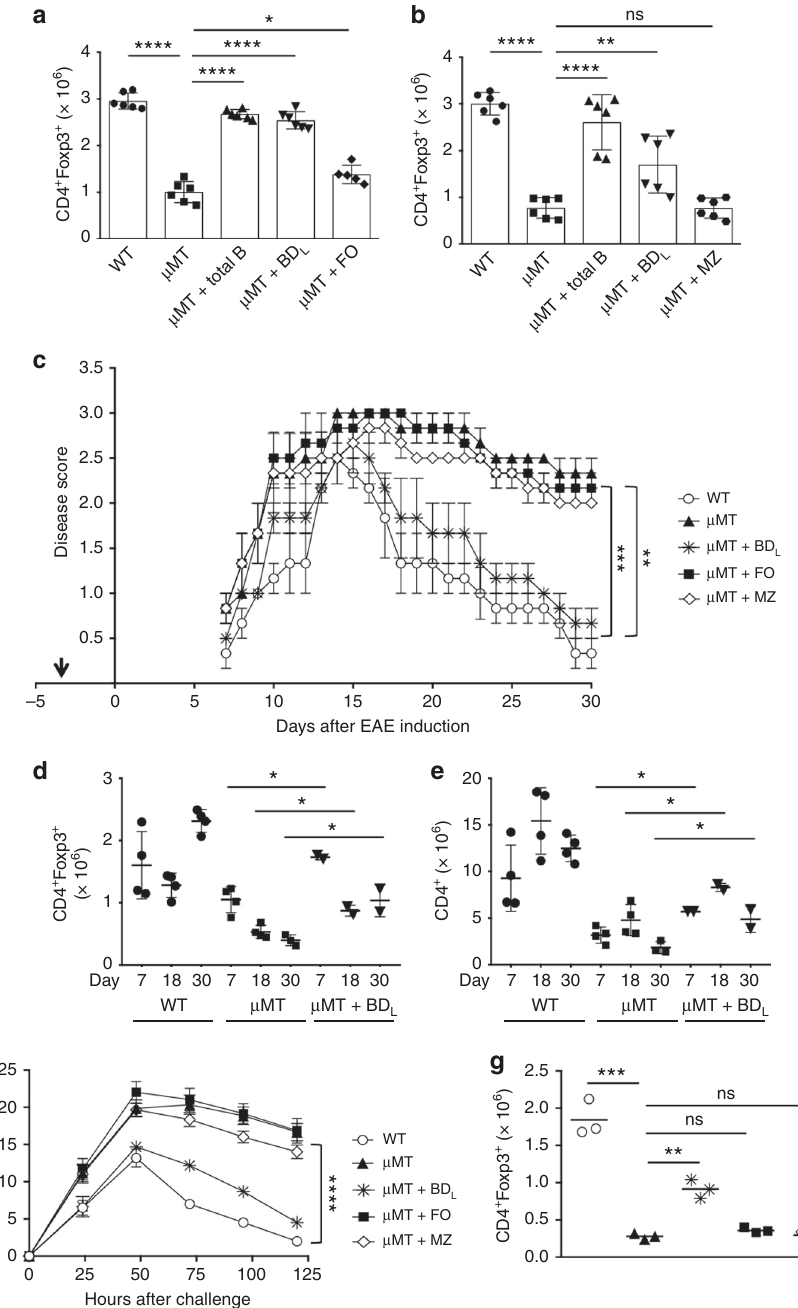
Fig. 3 Splenic BD L exhibit regulatory activity while FO and MZ B cells do not. a , b B10.PL μ MT ( μ MT) mice were treated with PBS or reconstituted with 10×10 6 FACS-puri fi ed splenic total (B220 + ) or 5 x 10 6 BD L ( a , b ), FO ( a ), or MZ ( b ) B cells from anti-CD20 IgG 1 -treated mice and the absolute number of splenic Treg was determined by fl ow cytometry 10 days later. B10.PL (WT) mice received PBS. Pooled data from two independent experiments are shown. Individual data points (mice) are shown superimposed upon the mean ±SEM. a * p <0.05, μ MT vs. FO; **** p < 0.0001, WT vs. μ MT, μ MT vs. Total B and μ MT vs. BD L . b ** p <0.01, μ MT vs. BD L ; **** p < 0.0001, WT vs. μ MT and μ MT vs. Total B. ns = not signi fi cant. c – e B10.PL (WT) or B10.PL μ MT ( μ MT) mice were sublethally irradiated and 5× 10 6 BD L , FO, or MZ B cells were adoptively transferred into B10.PL μ MT mice (arrow) and 3 days later EAE was induced as for Fig. 1e. c EAE scores were assessed daily. The data shown are the mean±SEM daily disease score of three mice from one representative experiment of three. ** p <0.01, WT vs. μ MT, WT vs. FO, μ MT vs. BD L , and μ MT vs. Total B; *** p <0.001, WT vs. MZ for the day 30 timepoint. d , e The absolute number of Treg (CD4 + Foxp3 + , d ) and conventional CD4 T cells (CD4 + Foxp3 − , e ) was determined in the spleen by fl ow cytometry on days 7, 18, and 30 following EAE induction. n = 2 – 4. * p <0.05. f , g CHS was induced in C57BL/6 WT or μ MT mice treated with PBS or μ MT mice that had received 5× 10 6 BD L , FO, or MZ B cells by painting one ear with 3% oxazolone on days 0 and 6. f Ear thickness was measured every 24h for 6 days. Data shown are the mean change in ear thickness±SEM from time 0 measured just prior to the second treatment. n = 6. **** p < 0.0001, WT vs. μ MT, MZ and FO WT and μ MT vs. μ MT + BD L for the 120h timepoint. g CD4 + Foxp3 + Treg were quantitated in the spleen at 120 h. ** p < 0.01, μ MT vs. μ MT + BD L; *** p < 0.0001, WT vs. μ MT for the 120h timepoint. n = 3 mice. ns = not signi fi cant. Statistical signi fi cance was determined using the unpaired t